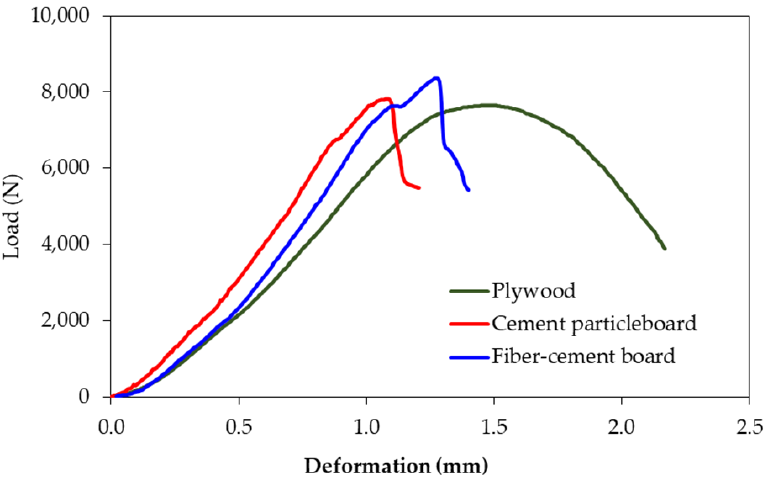
Figure 7. Representative load-deformation curves from the compression test parallel to the surface of the surface materials.